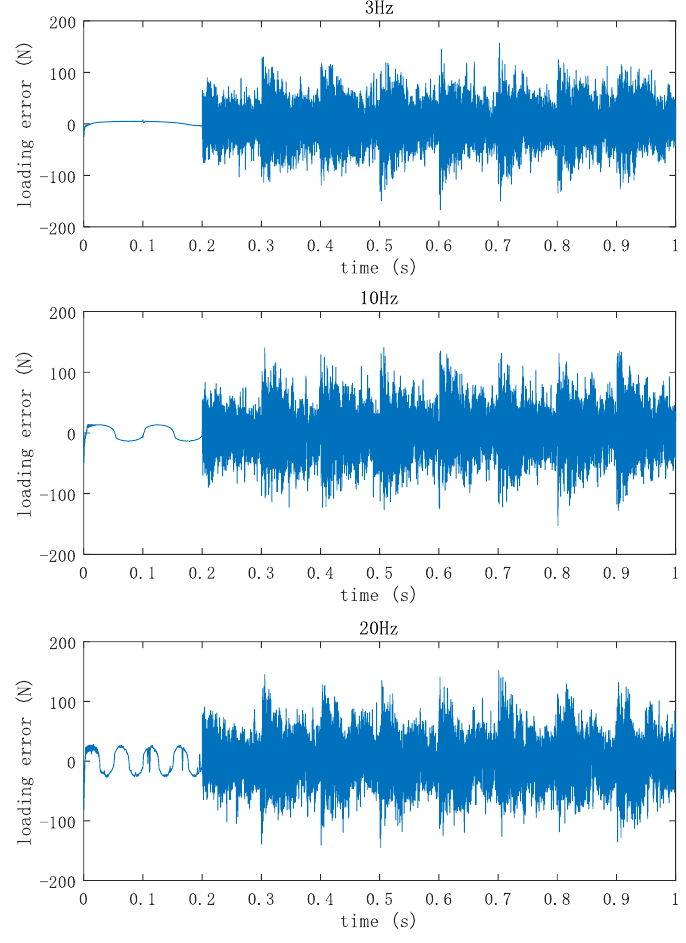
Figure 20. System loading error at different frequencies.